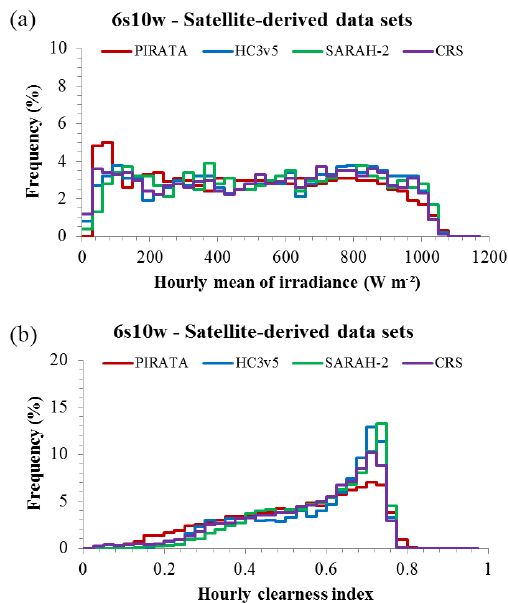
Figure 3. Frequency distributions of PIRATA measurements (red) and data sets (HC3v5: blue, SARAH-2: green, CRS: purple) at 6 ◦ S, 10 ◦ W for E (a) and KT (b) . If the coloured line is above (below) the red one for a given sub-range of values, it means that the data set produces these values too frequently (too rarely) with respect to the PIRATA measurements.